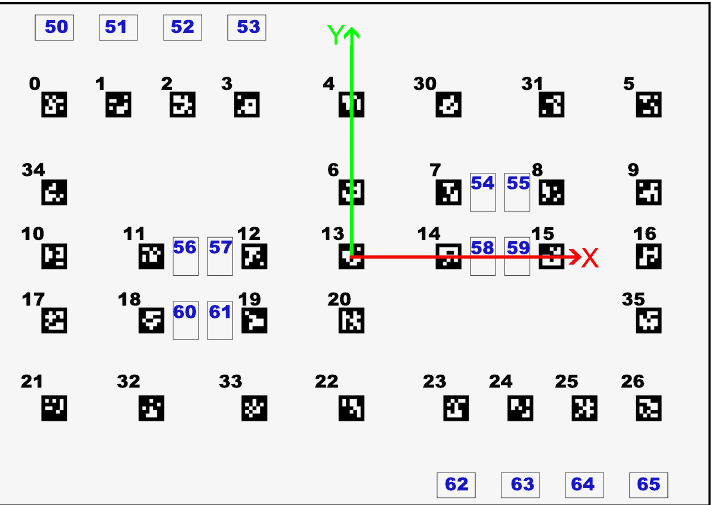
Figure 1. Top view of the RobotAtFactory 4.0 competition field with axes’ representation for identi- fication of each ArUco marker, where black numbers indicate tags on the floor and blue numbers indicate tags on the